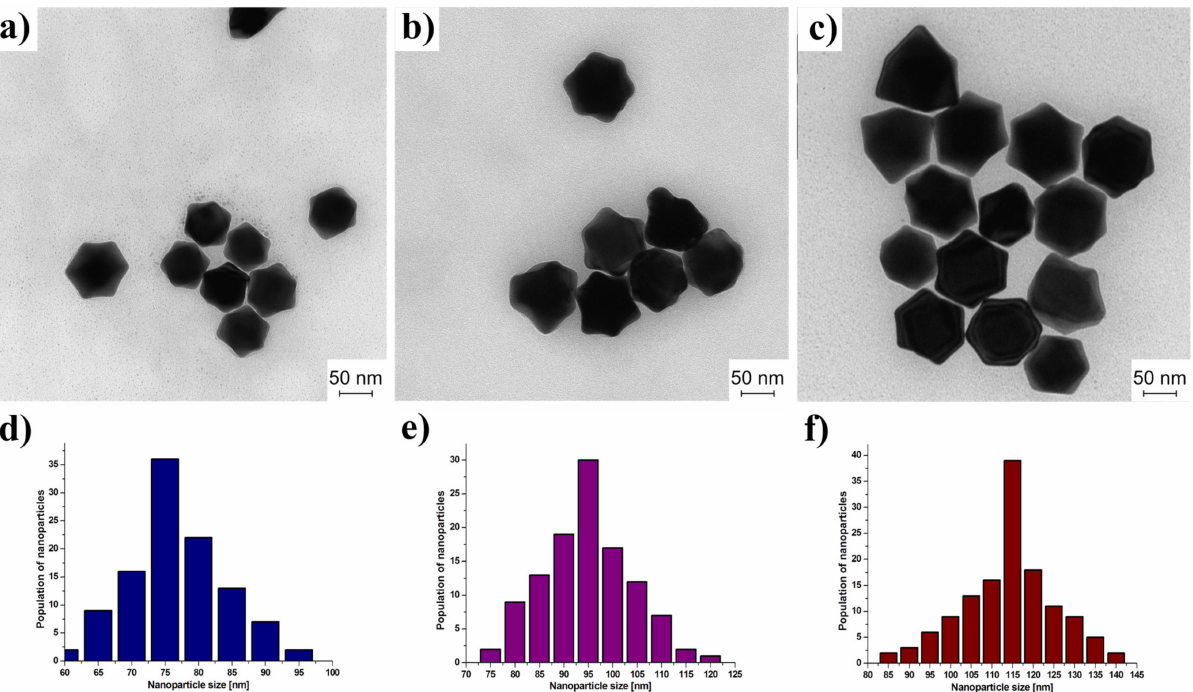
Figure 8. TEM micrographs of trisoctahedral gold nanoparticles of various diameters: ( a ) 70 nm; ( b ) 94 nm; and ( c ) 115 nm. Size distribution of nanoparticles: ( d ) 70 nm; ( e ) 94 nm; and ( f ) 115